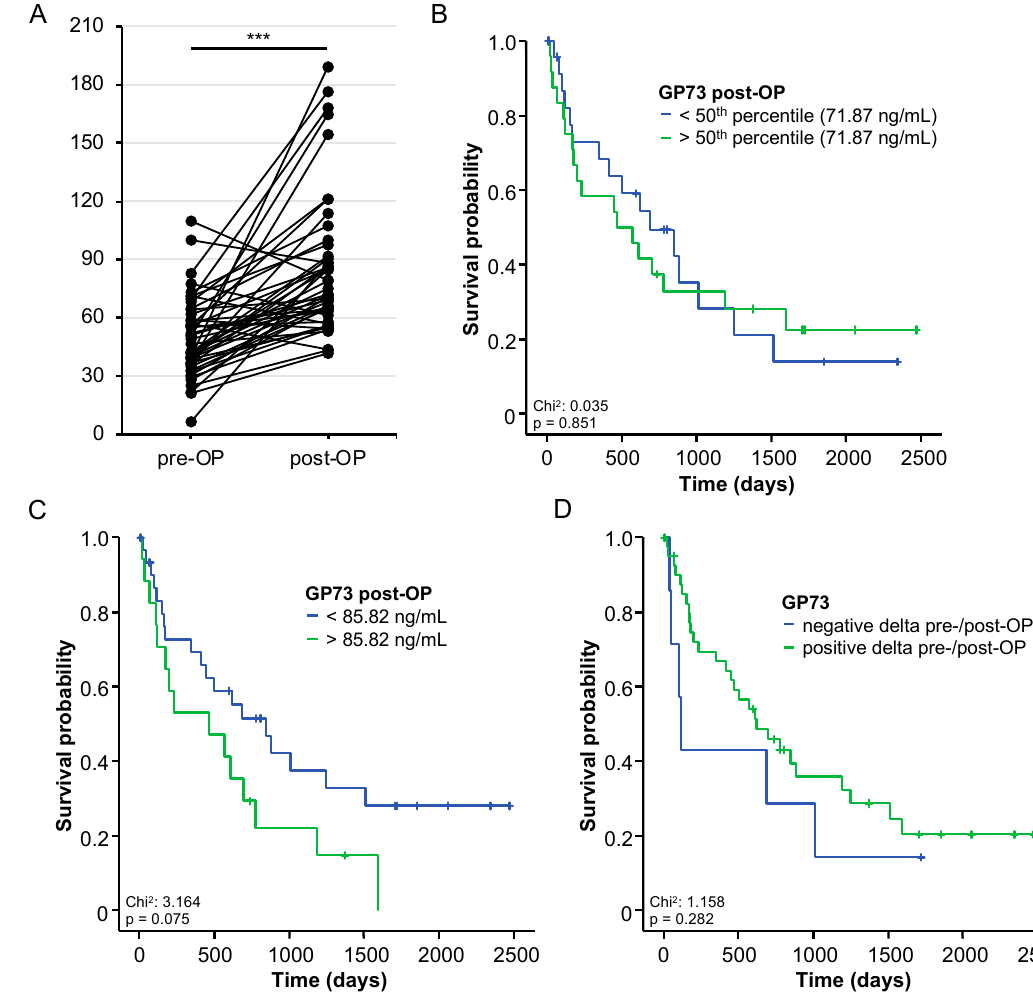
Figure 4. Postoperative GP73 levels and patients’ outcome. ( A ) Circulating levels of GP73 are significantly elevated at days 6 or 7 following tumor resection. *** p < 0.001. ( B ) Postoperative GP73 levels above the 50th percentile (51.08 ng/mL) are unsuitable to predict postoperative outcome. ( C ) BTC patients with postoperative GP73 levels above >85.82 ng/mL show a strong trend towards an impaired overall survival, though statistical significance is not reached. ( D ) The overall survival is not significantly altered between patients with increasing or decreasing GP73 levels after tumor resection.